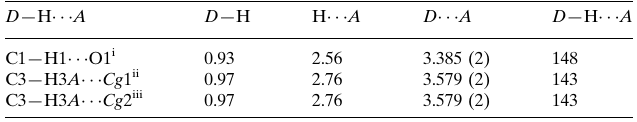
Hydrogen-bond geometry (A˚ , (cid:4) ). Cg 1 and Cg 2 are the centroids of the C4–C7/C7 i /C8 and C4 i –C7 i /C7/C8 i rings,